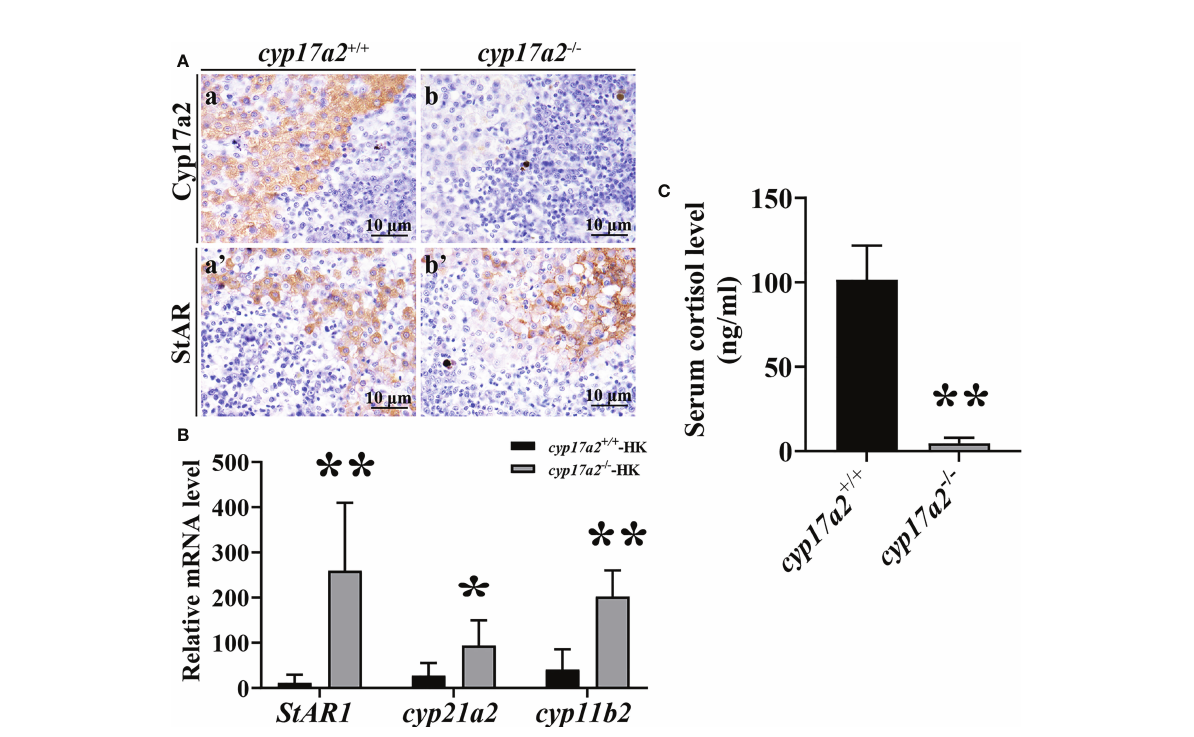
FIGURE 3 Effects of cyp17a2 de fi ciency on steroid production in head-kidney of tilapia. (A) , Immunohistochemistry of Cyp17a2 (a and b) and StAR (a ’ and b ’ ) in the head-kidney of cyp17a2 +/+ and cyp17a2 -/- XY tilapia. (B) , Expression level of StAR1 , cyp21a2 , and cyp11b2 in the head-kidney of cyp17a2 +/+ (n=3) and cyp17a2 -/- (n=3) fi sh detected by qRT-PCR. b -actin was used as a reference gene to normalize the expression values. (C) , Serum cortisol level in cyp17a2 +/+ (n=5) and cyp17a2 -/- (n=5) fi sh measured using an EIA kit. The data are reported as the means±SD. Asterisk above the error bar indicate signi fi cant differences between groups tested by Student ’ s t -test (*, P<0.05; **,